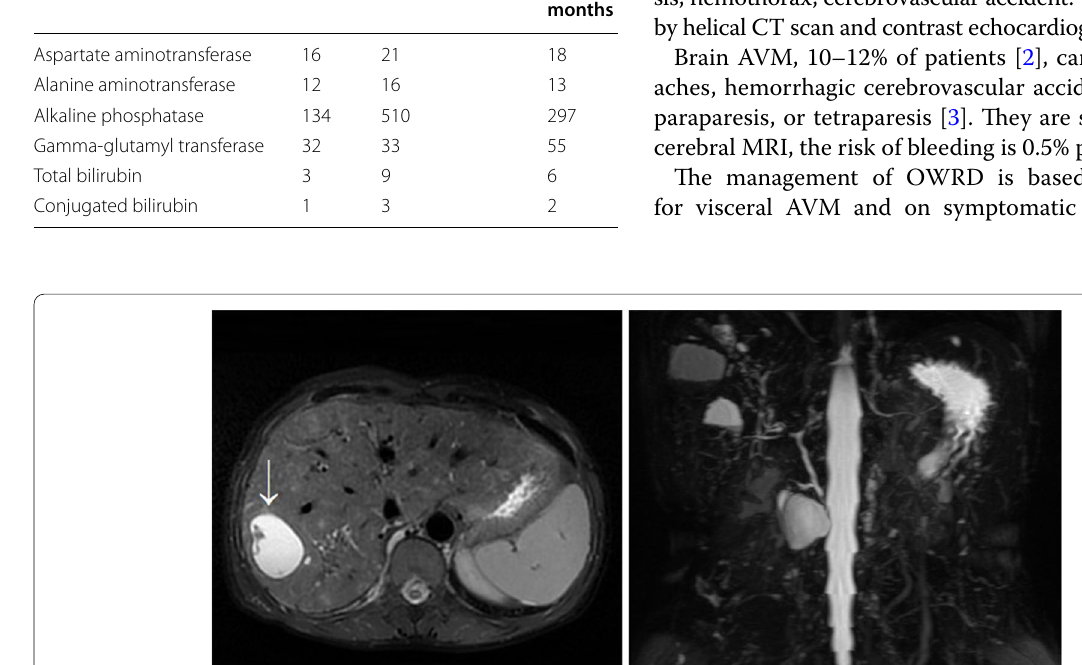
Table 2 Evolution of the level of liver enzymes of our patient Start